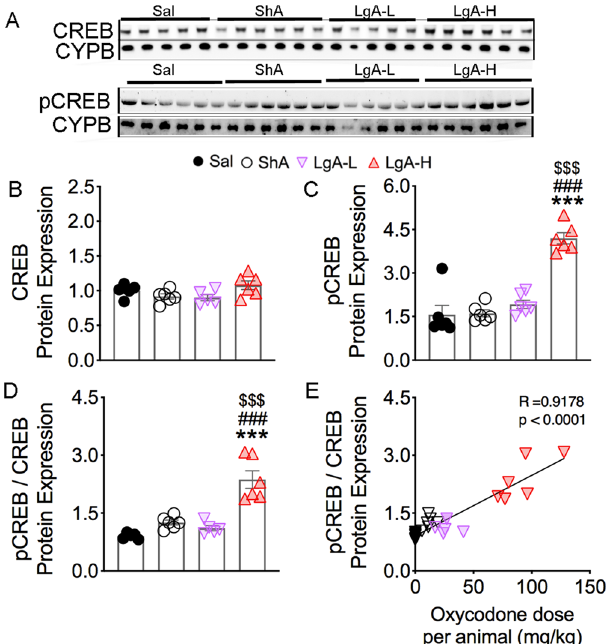
Figure 4. Increased phosphorylation of CREB protein levels in the LgA-H rats. ( A ) Images of western blot and ( B, C ) quantification of CREB and pCREB. ( B ) CREB protein levels show no significant changes. ( C ) pCREB is significantly increases in LgA-L and LgA-H rats. ( D ) pCREB/CREB ratios are increased in the LgA-H rats and ( E ) correlated with amount of oxycodone. (n = 5–6 Sal; n = 6 ShA; n = 5–6 LgA-L; n = 6 LgA-H). Full-length blots are presented in Supplementary Figure S5. Key to statistics: *, ** = p < 0.05, 0.01, respectively, in comparison to Sal rats; #, ## = p < 0.05, 0.01, respectively, in comparison to SHA rats; $$ = p < 0.01 in comparison to LgA-L rats. Statistical analyses are as described in Fig.